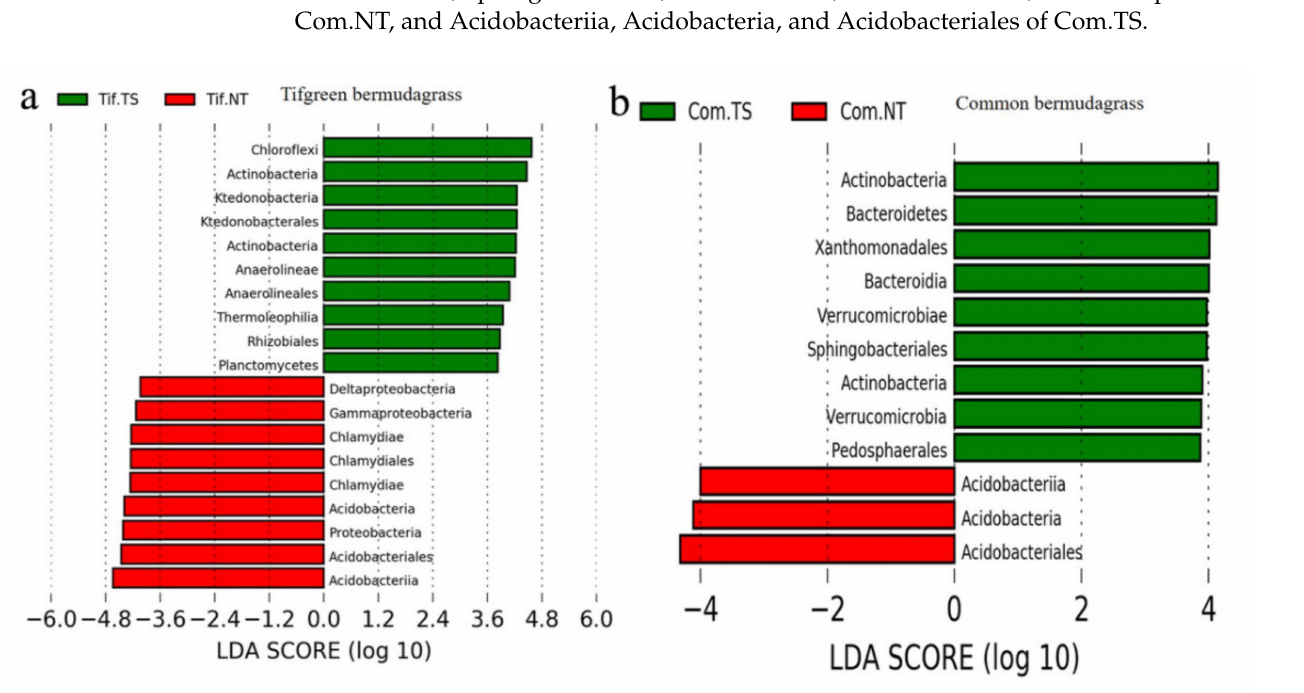
Figure 7. LDA effect size (LEfSe) analysis on soil bacteria under traffic stress in Tifgreen Bermudagrass ( a ) and Common bermudagrass ( b ). Note: Tif.TS, Tifgreen bermudagrass with traffic treatment; Tif.NT, Tifgreen bermudagrass with non-traffic treatment; Com.TS, Common bermudagrass with traffic treatment; Com.NT, Common bermudagrass with non-traffic